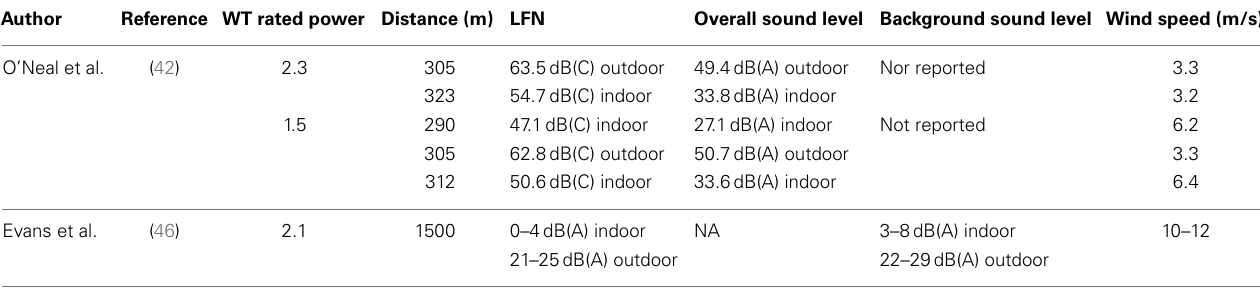
Table 3 | Review of reported wind turbine LFN emissions (reported after 2010 a ) .